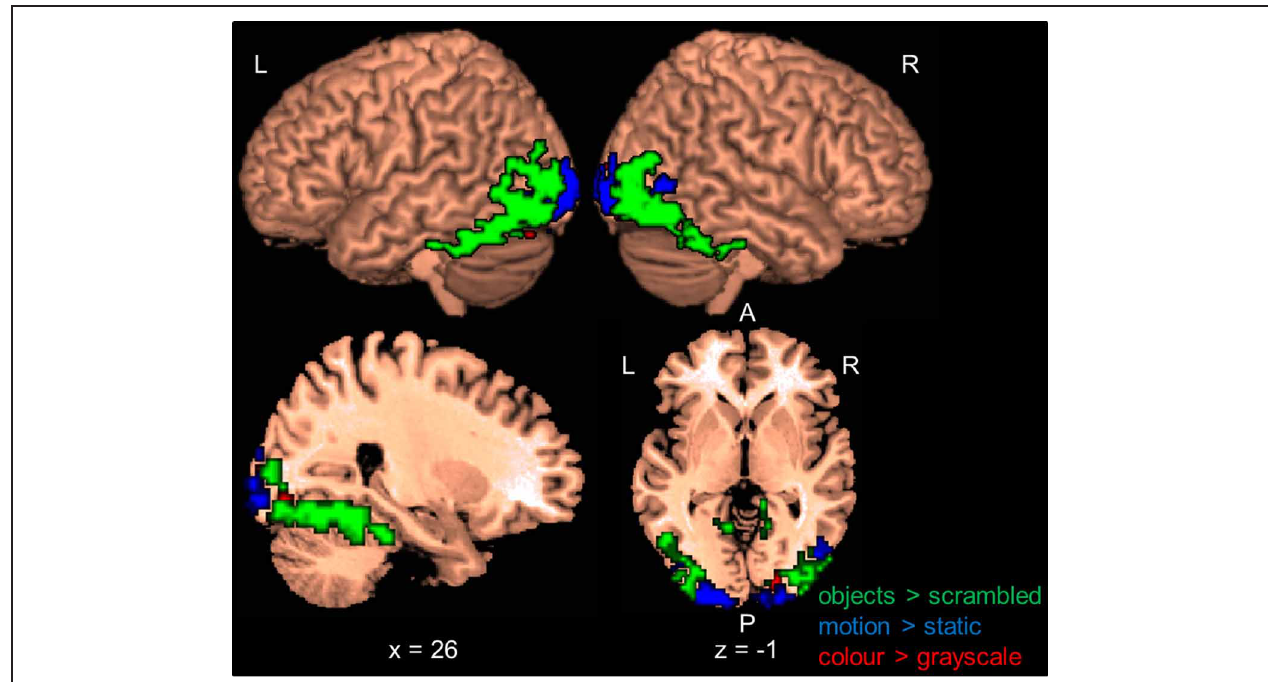
FIGURE 1 | Results of the functional shape, motion, and color localizers for the whole-brain group-analysis ( N = 12). Areas are significant at p < 0 . 05, FDR-corrected at the cluster level for multiple